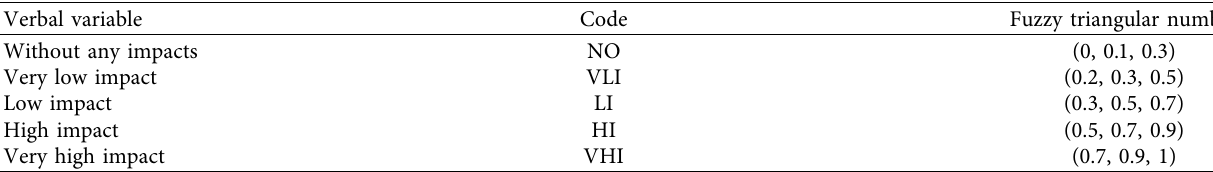
Table 6: Fuzzy verbal scales for the opinions of